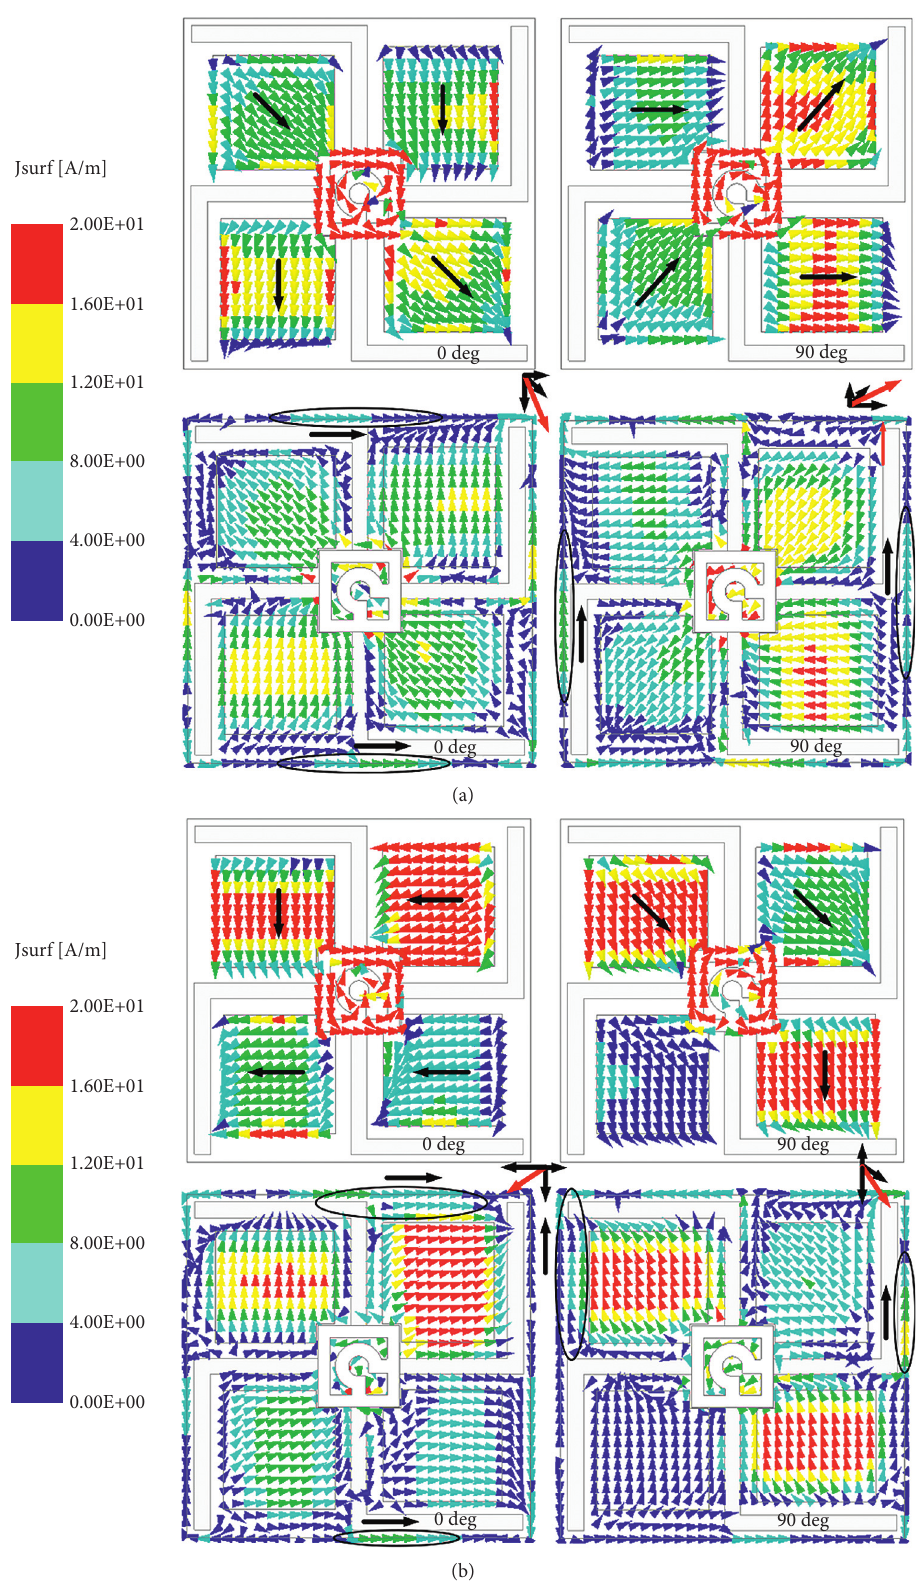
Figure 3: Simulated vector electric field distribution in the CP MSA and its corresponding principal planes with different phases of 0 ° and 90 ° at (a) 4.7GHz and (b) 5.2GHz,